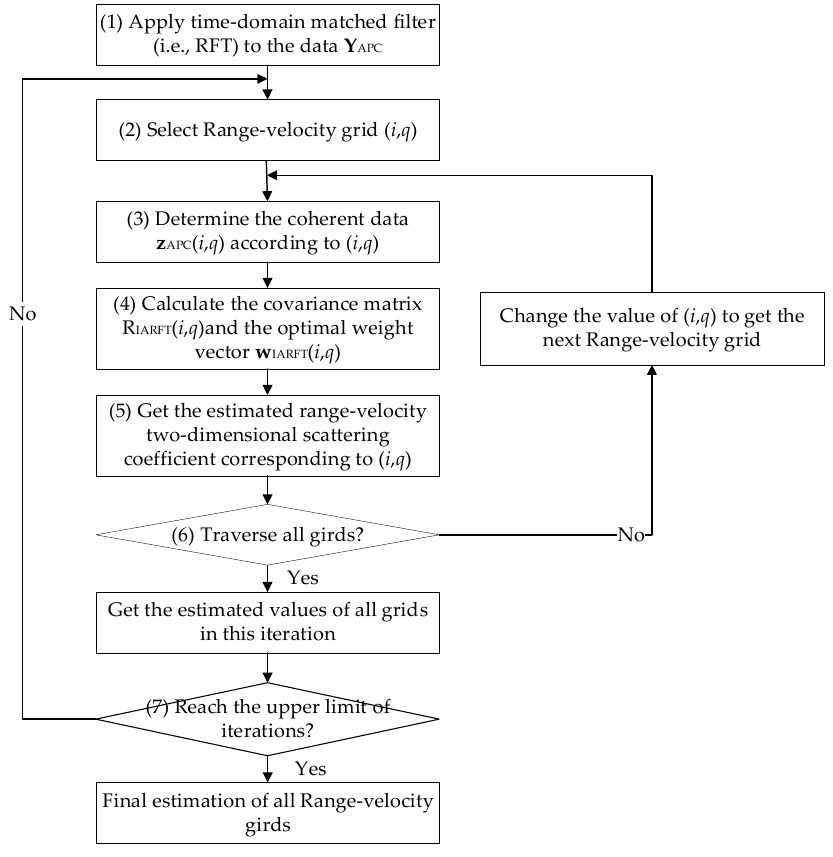
Figure 4. Flow chart of the IARFT